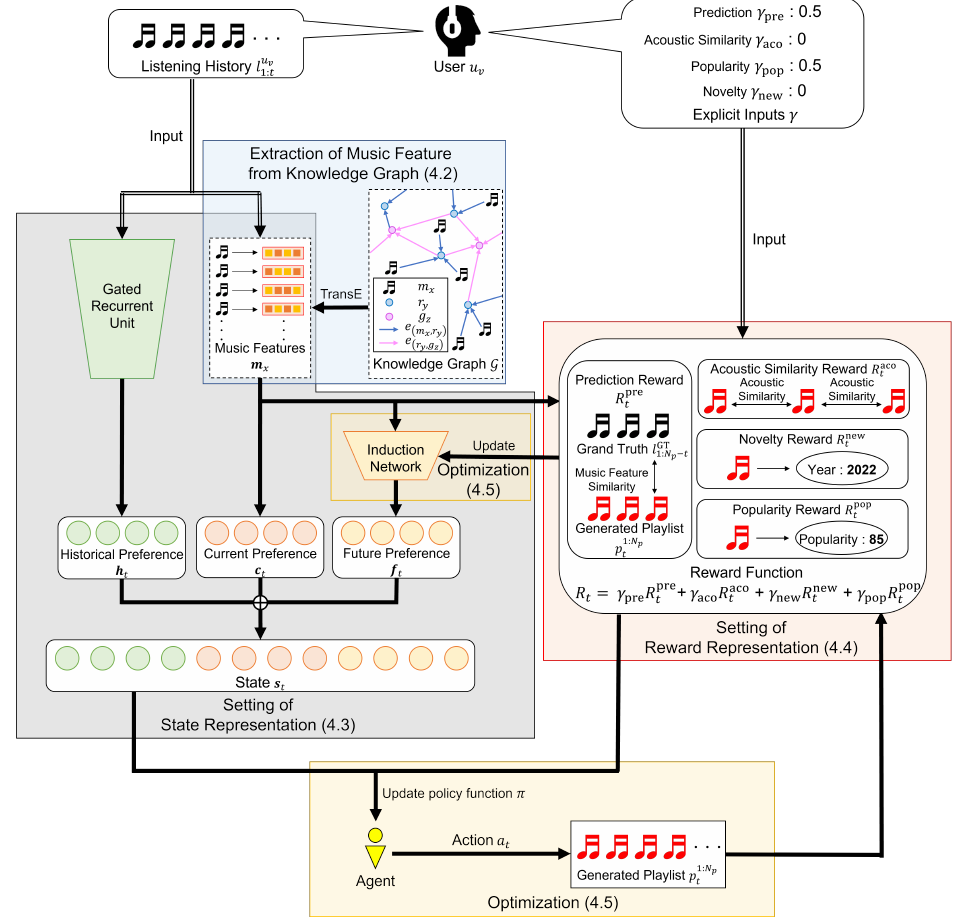
Figure 1. The overview of the proposed method. Based on the target user’s listening history l u v his/her explicit inputs γ , our model learns the policy function π for the agent that generates the 1: N p playlist p